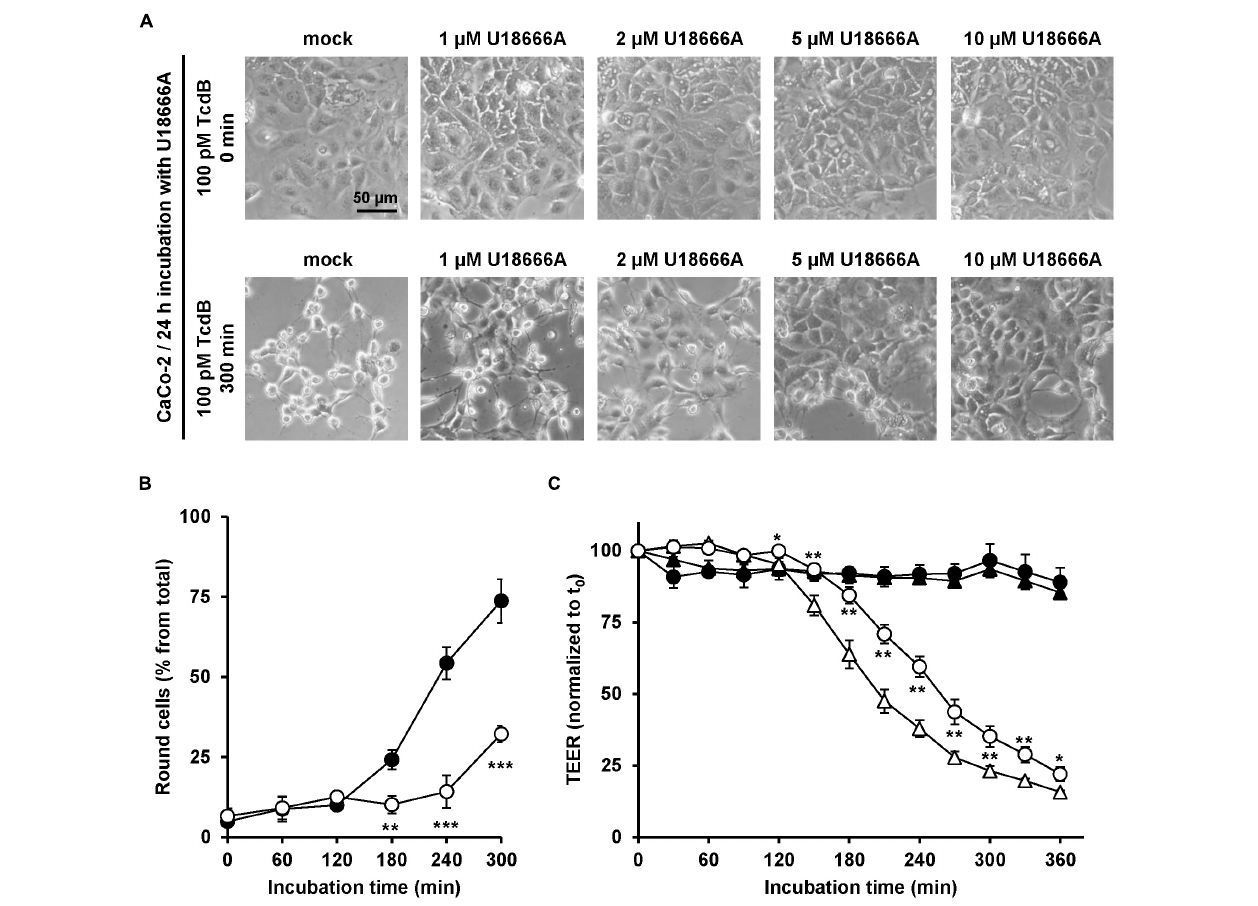
FIGURE 5 | Effect of U18666A on the intoxication of CaCo-2 cells by TcdB. (A) After pretreatment of CaCo-2 cells for 24 h with increasing concentrations of U18666A as indicated or without pretreatment (mock), cells were intoxicated with 100 pM TcdB for 300 min and cell morphology analyzed microscopically. Representative images after time point 0 min (upper row) and 300 min (lower row) are shown. (B) Quantification of the TcdB-induced cell rounding over time in mock-treated (black filled circles) and 24 h U18666A (10 µ M)-pretreated CaCo-2 cells (white filled circles). Graph shows mean values (percentage of round cells) from three parallel experiments performed in independent wells. Error bars represent ± SD. Asterisks indicate statistical significance compared to control (mock-treated CaCo-2 cells) with ** p < 0.01 and *** p < 0.001. (C) CaCo-2 cells grown in inserts were pretreated for 24 h with 10 µ M U18666A (circles) or were left without pretreatment (triangles), prior to apical addition of 100 pM TcdB (white filled circles and triangles) at time point 0 (t 0 ) and measurement of the transepithelial electrical resistance (TEER) at indicated incubation times. Parallel samples were not treated with TcdB (black filled circles and triangles). Diagram shows relative TEER values normalized to time point 0 (t 0 ). Error bars represent ± SD. Asterisks indicate statistical significance at each time point between white filled triangles (–U18666A/+TcdB) and white filled circles (+U18666A/+TcdB), with * p < 0.05 and ** p <